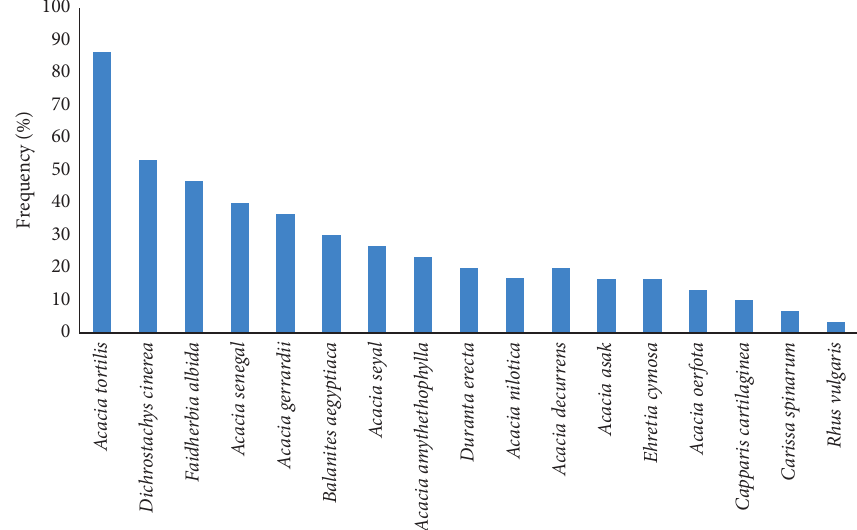
Figure 3: Frequency of occurrence of woody species in protected woodland.